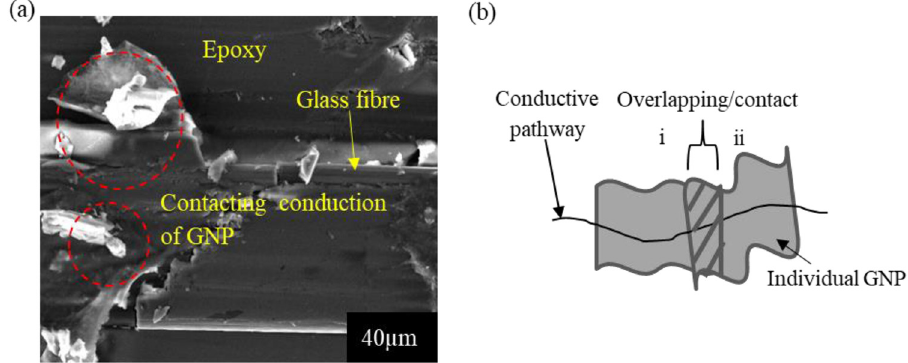
Figure 7: Contacting conduction: ( a ) FESEM image of possible contacting conduction among GNPs and ( b ) modelling distribution of GNP in epoxy.